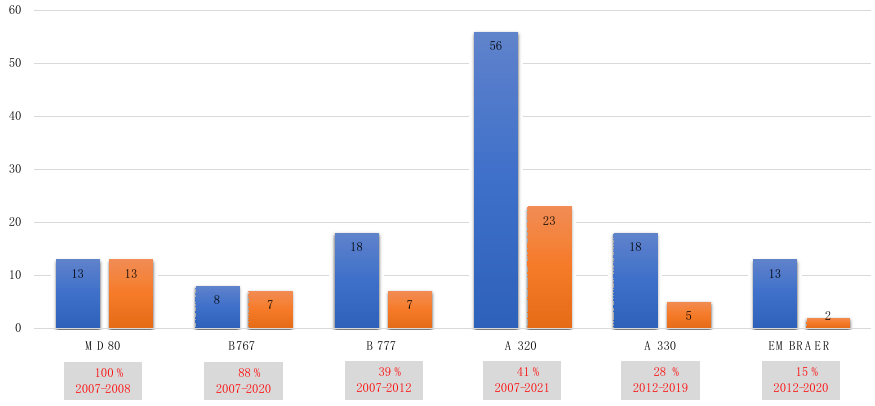
Figure 5. Number of examined airplanes (blue) and number of Legionella- positive airplanes (orange) for the entire period of examination.